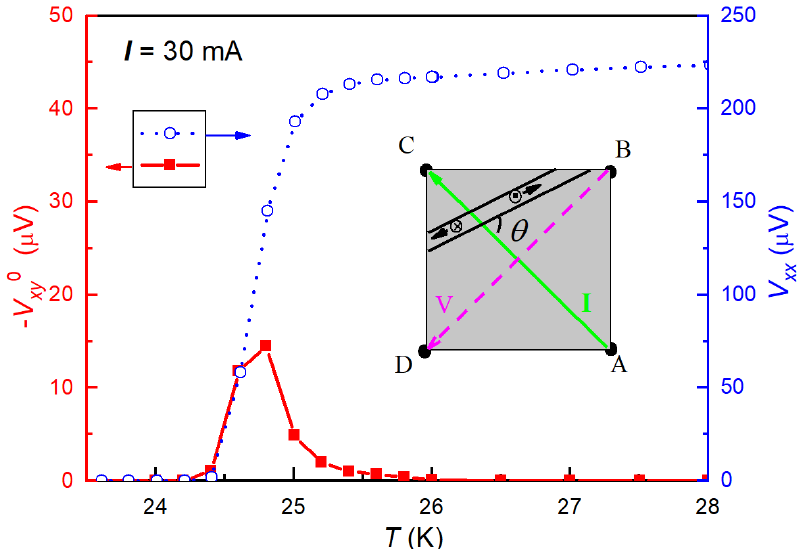
Figure 3. Temperature dependence of the zero-field transverse (left axis) and longitudinal (right axis) voltages for Ba(Fe 0.914 Co 0.086 ) 2 As 2 crystals. The transverse voltage was obtained by V 0 xy = ( V BD/AC − V AC/BD )/2, and the inset depicts the guided motion of an unbound vortex pair as well as the configuration for the measurement of V BD/AC .